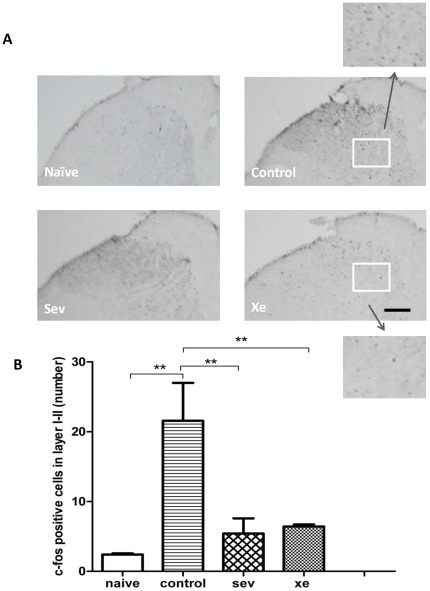
c-Fos expression in the spinal.Rats were divided into naïve group (virgin female rats exposed in 30% oxygen balanced by 70% nitrogen), control group (parturient rats exposed in 30% oxygen balanced by 70% nitrogen), sevoflurane group (parturient rats exposed in 0.35% sevoflurane in 30% oxygen balanced by nitrogen), or xenon group (parturient rats exposed in 35% xenon in 30% oxygen balanced by nitrogen). Photomicrographs show c-Fos expression in the dorsal horn at the lumbosacral level of the spinal cord (A). B shows the quantification of c-Fos positive cells. Data are expressed as mean ± SEM (n = 4). **p<0.01. Bar = 100 µm. The inserted box indicates the area being subjected to high magnification image.